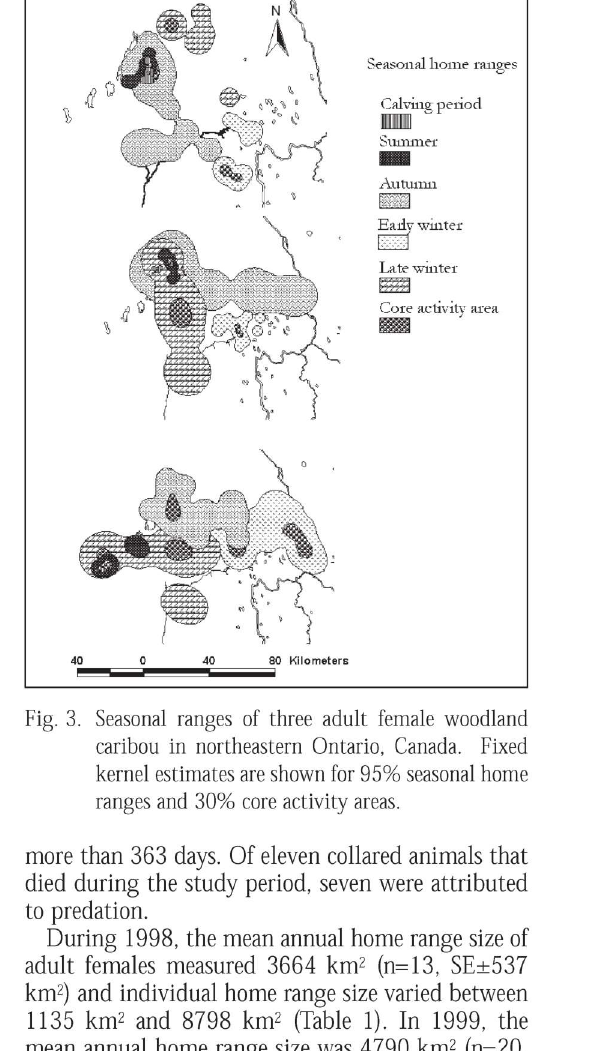
Fig. 2. Seasonal range sizes (km 2 ) of female woodland caribou in northeastern Ontario, Canada between 1998 and 2001. Bars indicate mean value plus 1 SE. Within each year, categories with different letters above the error bar are significantly differ¬ ent (ANOVA of log transformed data with post- hoc Tamhane confidence intervals, a = 0.05). No statistical comparisons were made between years.